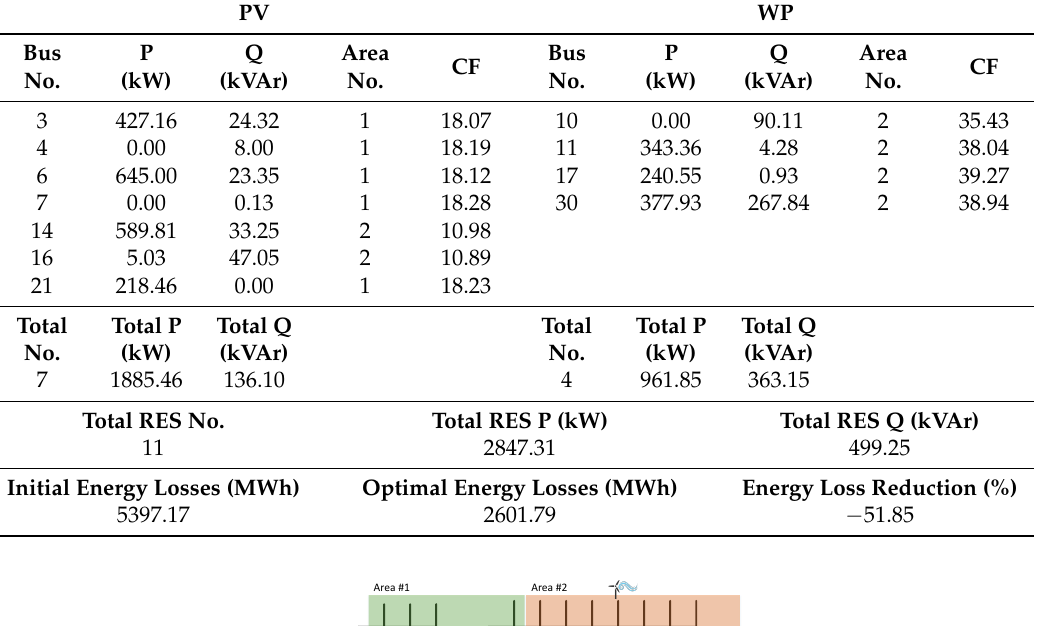
Table 8. Detailed Analysis—Scenario #1.